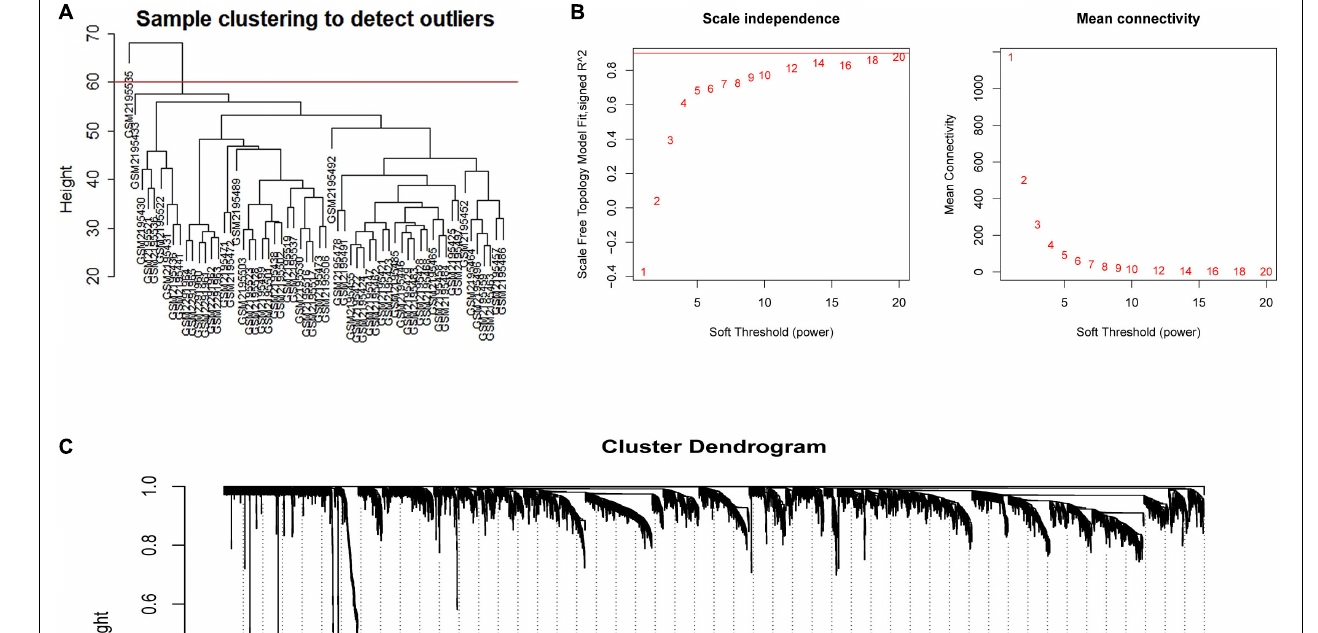
FIGURE 2 | Coexpression network establishment to identify modules related with HBV infection based on WGCNA. (A) HBV-related samples clustering to detect outliers. (B) The mean connectivity and scale-free fit index with different soft-thresholding powers. (C) A clustering dendrogram of coexpression modules screened on the basis of HBV-related samples from GSE83148. (D) Module-trait relationships between gene modules and HBV infection. (E) The correlation between module membership and gene significance in red module. HBV, hepatitis B virus.